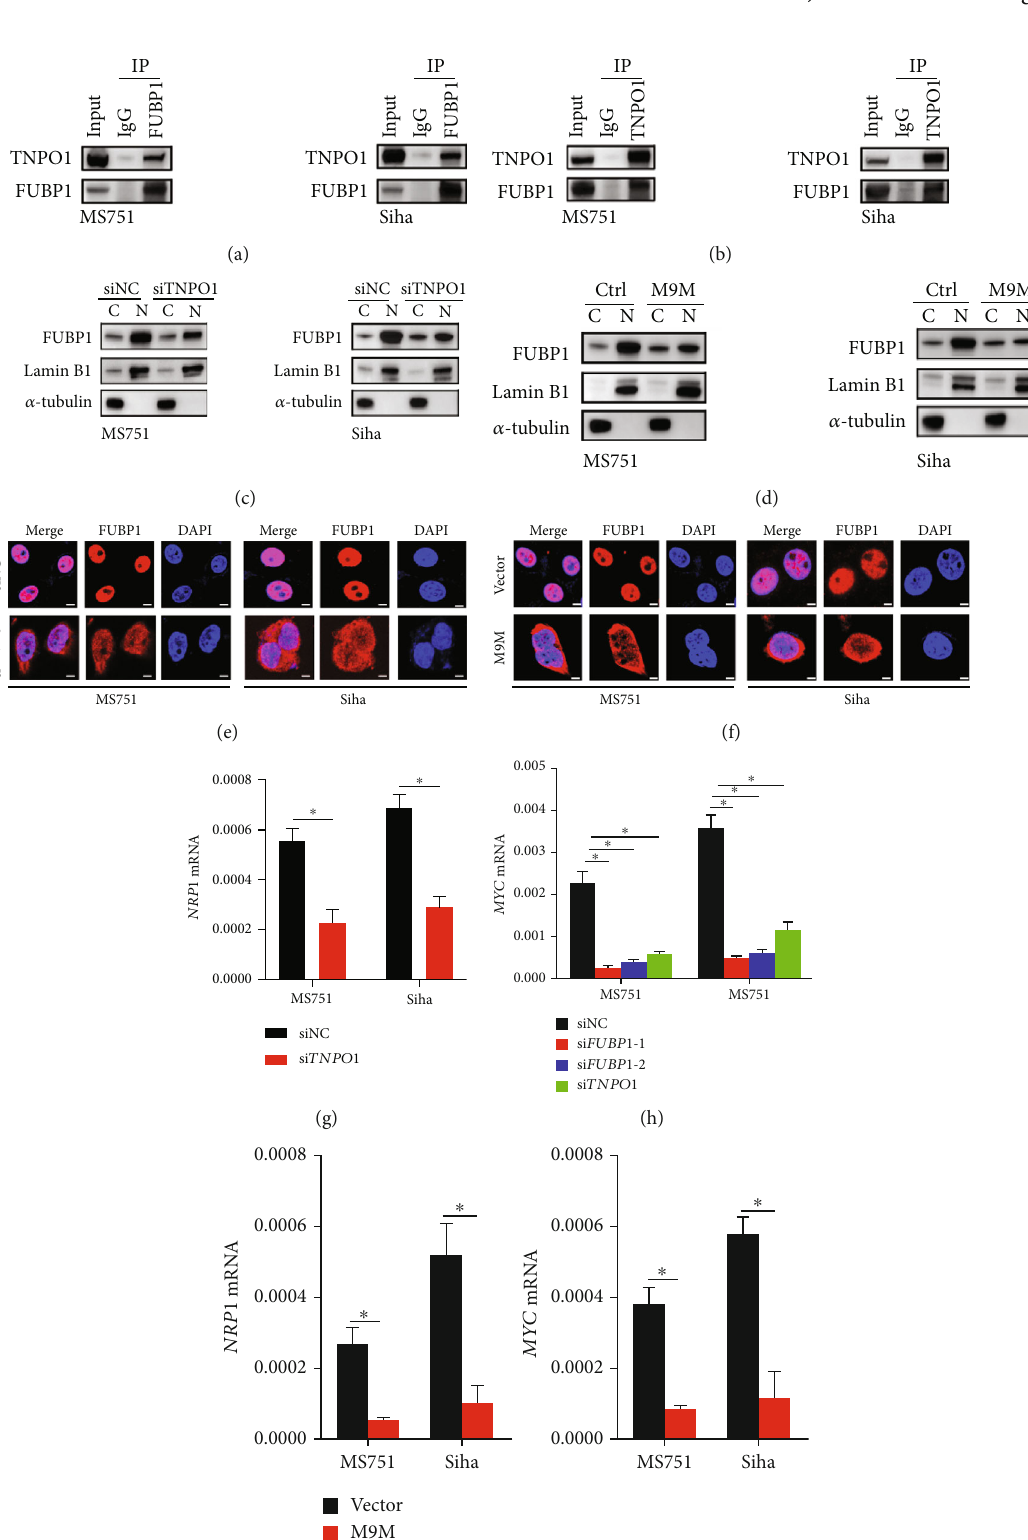
Figure 5: Karyopherin TNPO1 mediates nuclear import of FUBP1. (a) Immunoblots of the TNPO1 levels following immunoprecipitation of FUBP1 in MS751 and Siha cells. (b) Immunoblots of the FUBP1 levels following immunoprecipitation of TNPO1. (c, d) Immunoblots shows the FUBP1 levels in the nucleoplasm and cytoplasm after transfecting with siTNPO1 or M9M. (e, f) Confocal microscopy shows the FUBP1 protein after transfecting with siTNPO1 or M9M. (g, h) The mRNA level of NRP1 and MYC after FUBP1 or TNPO1 knockdown. (i) The mRNA level of NRP1 and MYC after M9M expression. Error bars represent mean ± standarderror of mean. Scar bar: 20 μ m. Two-tailed t -test, ∗ p < 0 : 05